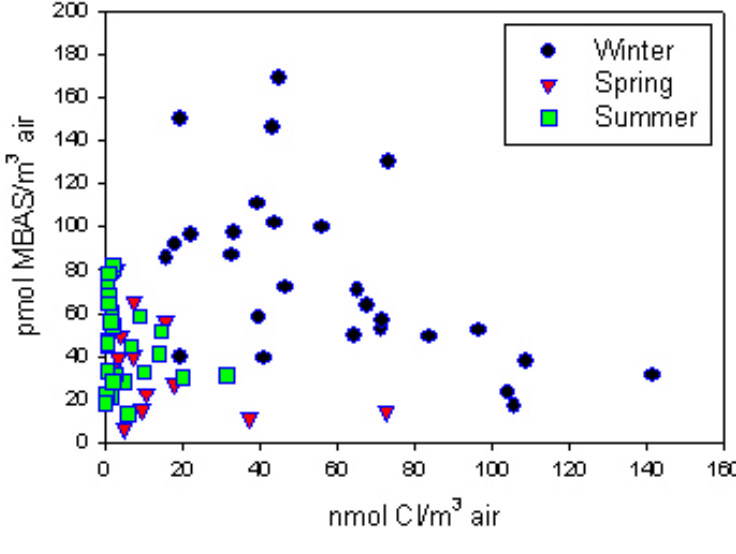
FIGURE 2. MBAS concentration in the atmosphere as a function of aerosol chloride